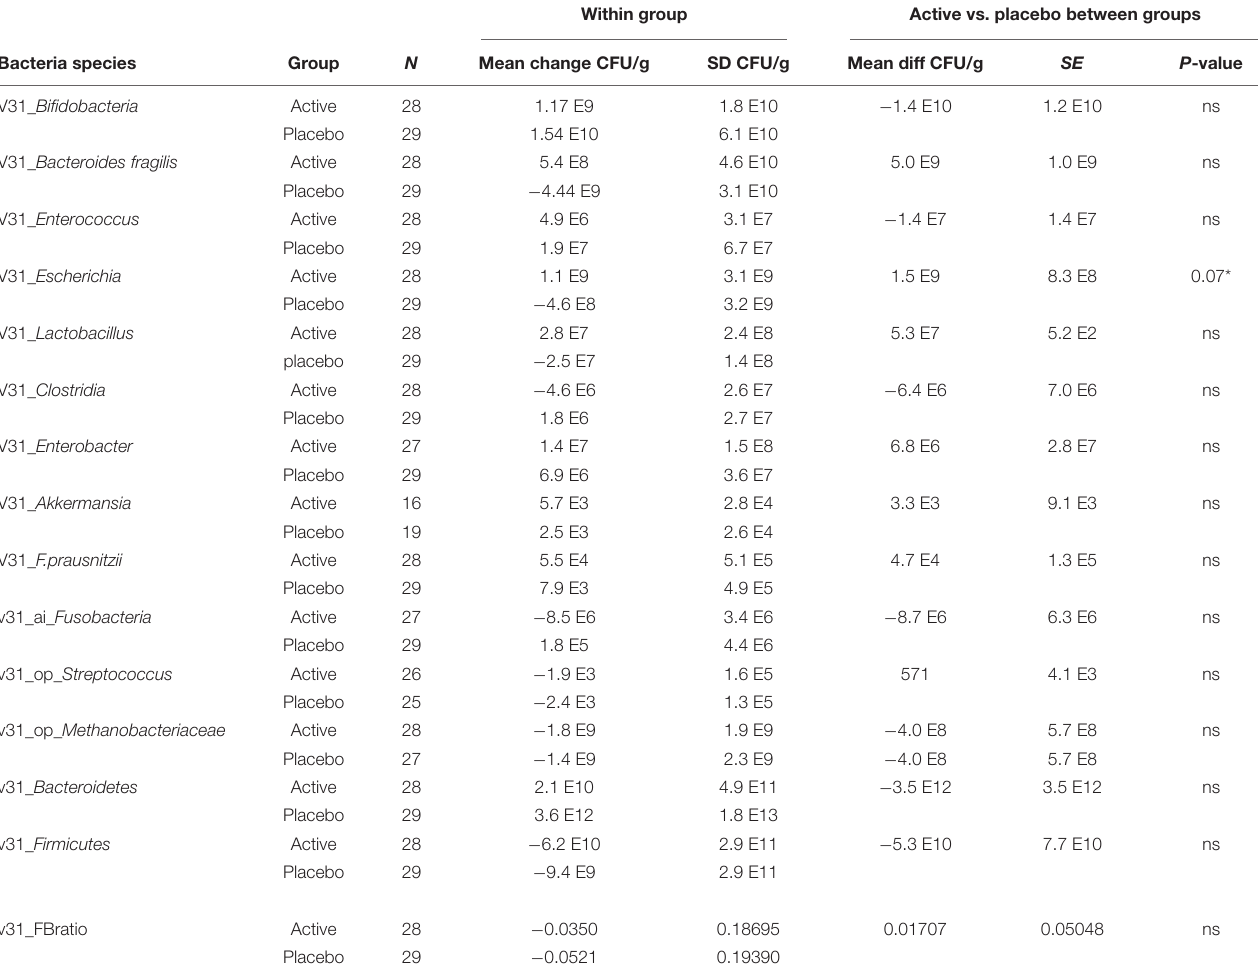
TABLE 8 | Microbiome change at 12 weeks compared with baseline.